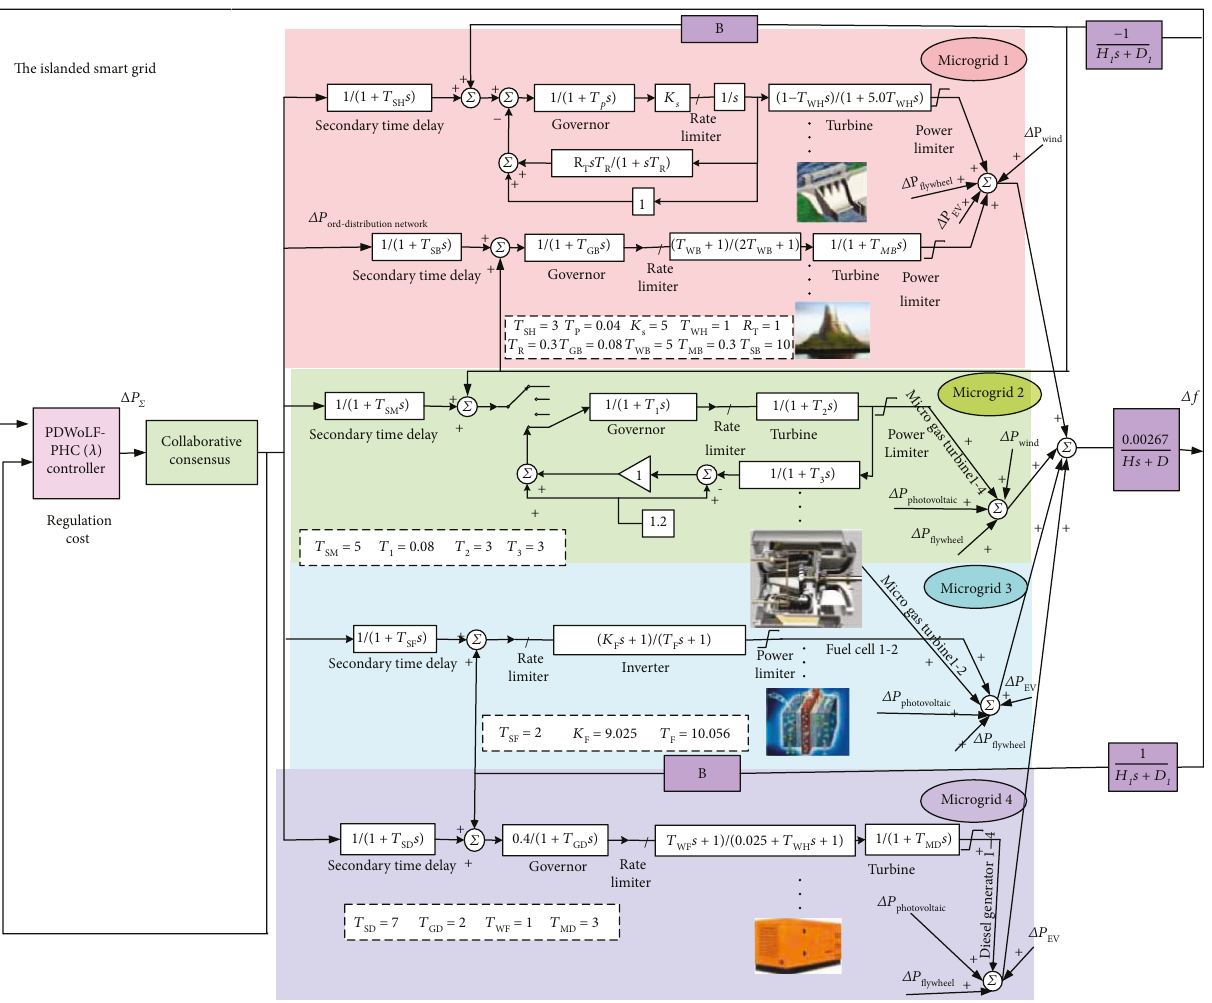
Figure 6: The structure of the islanded smart grid